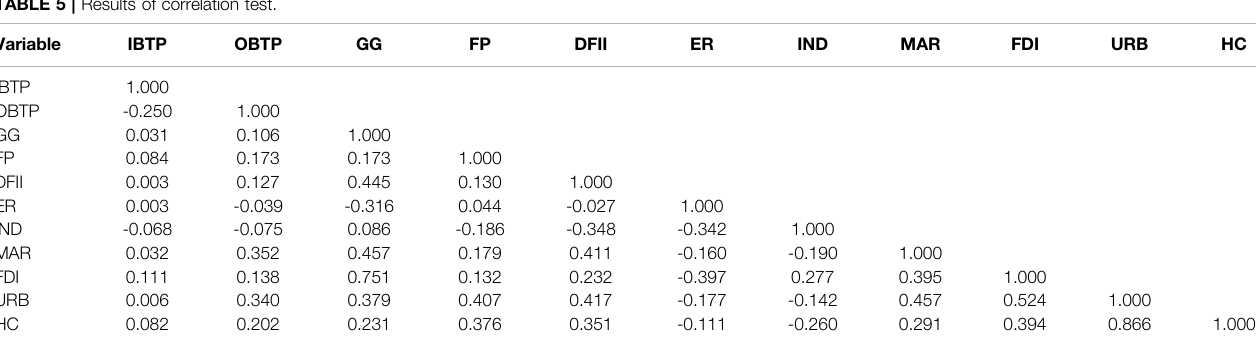
TABLE 5 | Results of correlation